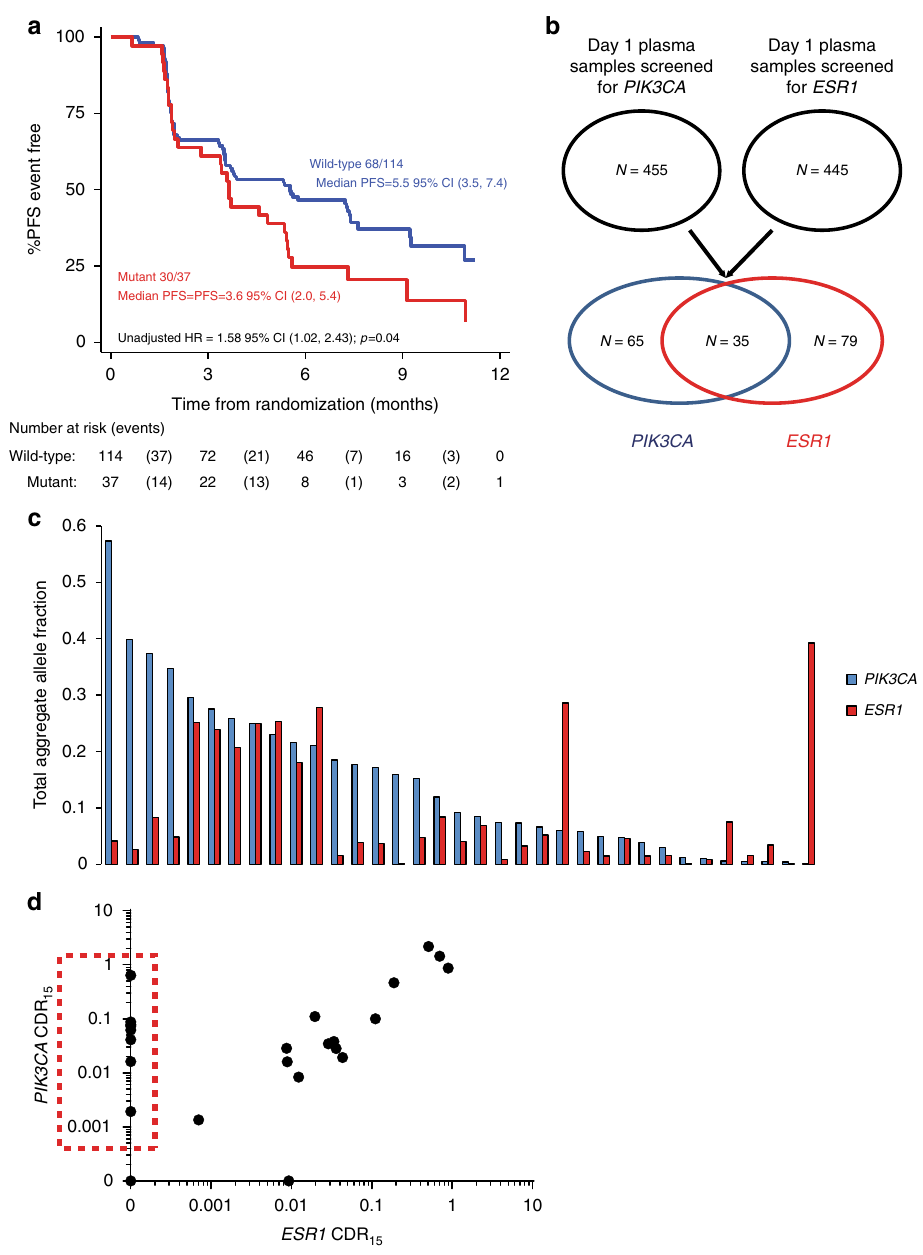
Fig. 4 ESR1 mutations may be sub clonal with distinct response to therapy. a Kaplan – Meier curves for PFS of patients with and without ESR1 mutations in day 1 baseline plasma randomized to placebo and fulvestrant in the PALOMA-3 trial, n = 151, updated from ref. 17 . b Overlap of baseline plasma PIK3CA and ESR1 mutations. c Baseline day 1 allele fraction comparison of aggregate PIK3CA mutations and aggregate ESR1 mutations in patients with mutations detected in both genes, n = 35. d Comparison of CDR 15 for PIK3CA mutation and ESR1 mutation in the same patient plasma samples, n = 25. The red dashed box highlights patients with loss of ESR1 mutation in plasma after 15 days treatment where PIK3CA mutation remained